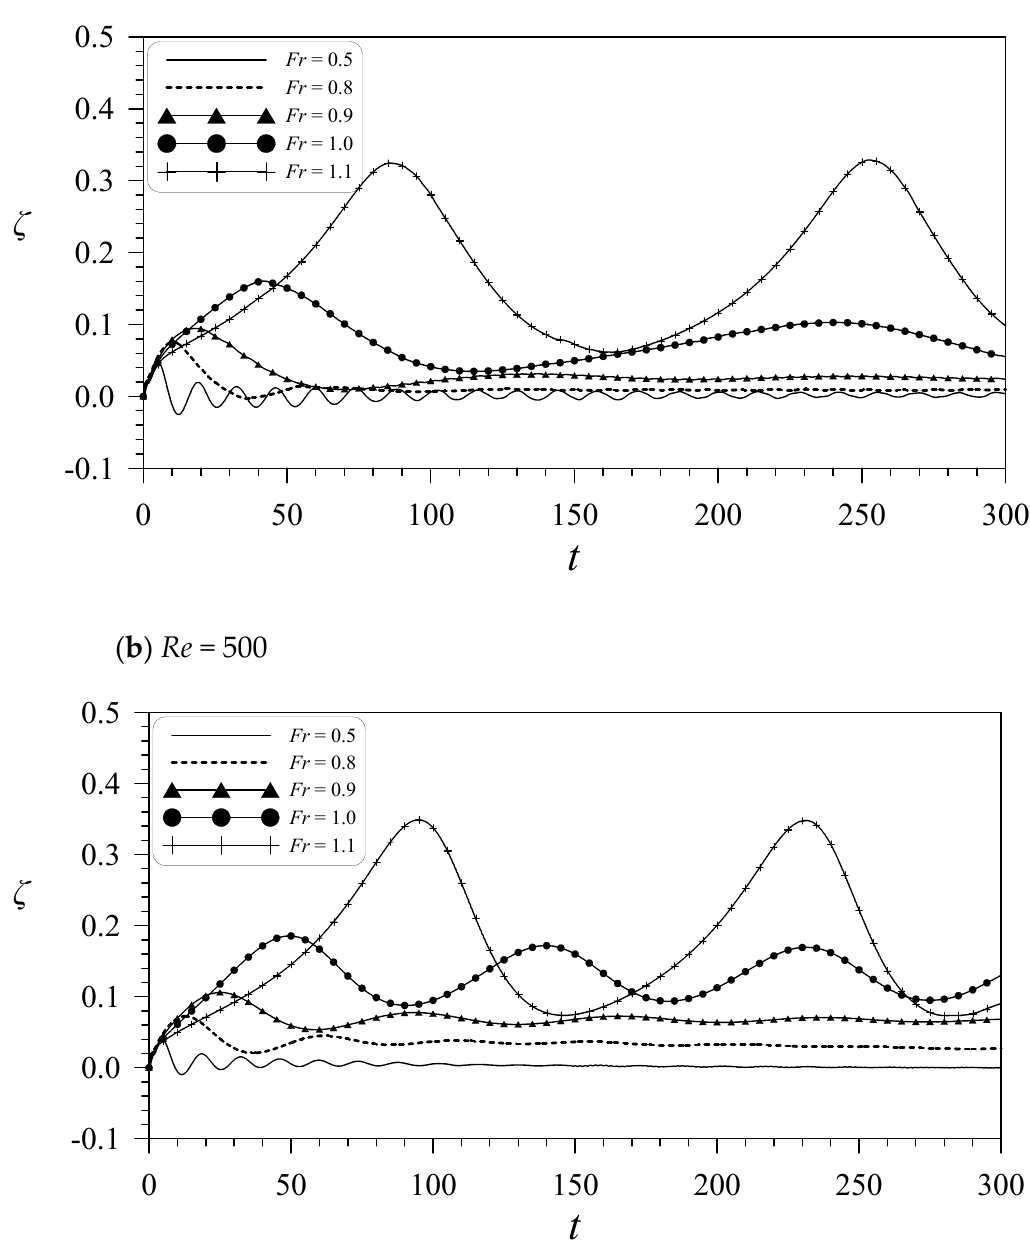
Figure 12. Free-surface elevation at x = − 0.5 for various Fr at ( a ) Re = 5000 and ( b ) Re = 500.